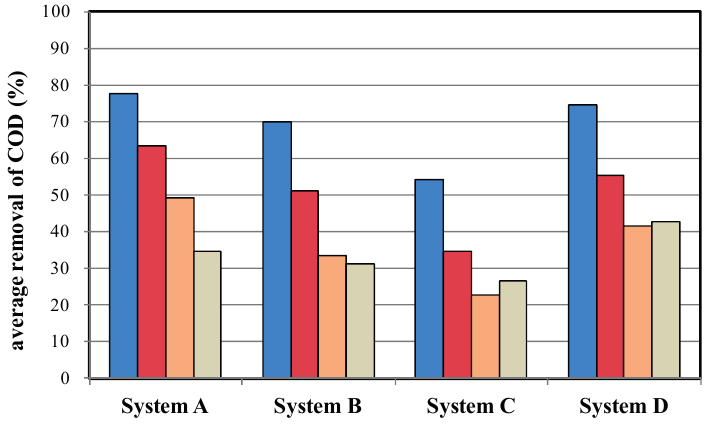
Figure 7. Average COD removal efficiency of the four MSL samples under various HLR